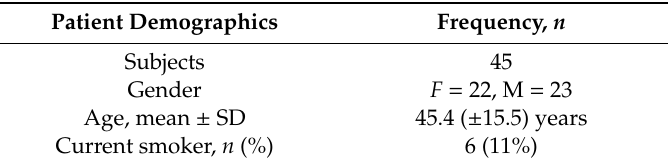
Table 1. Demographic characteristics of studied population